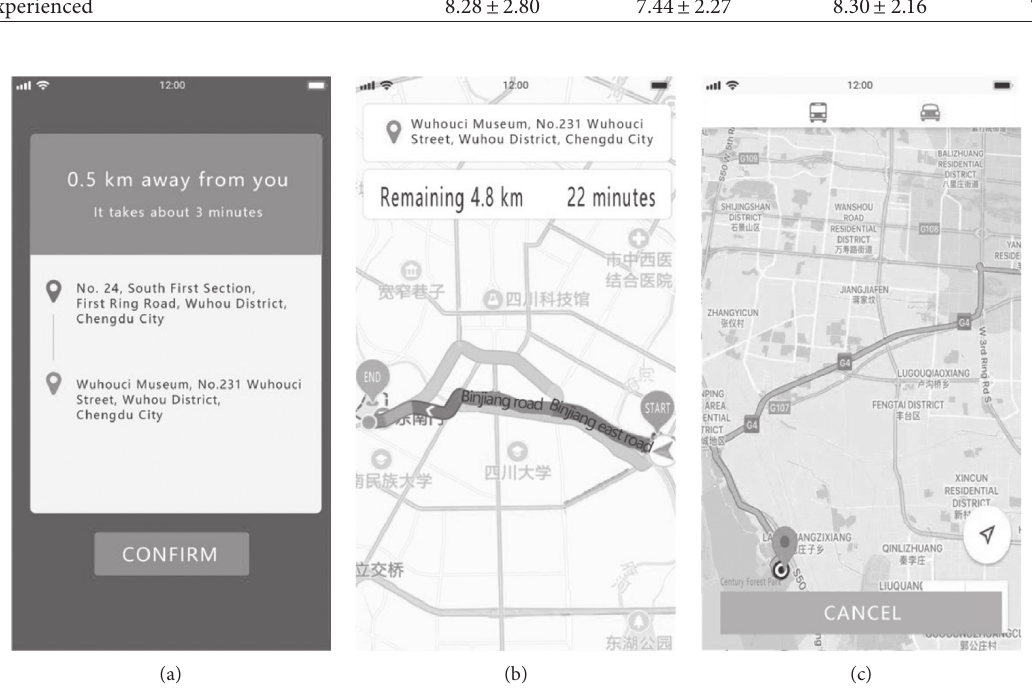
Figure 2: The interface of three experimental demos. (a) Ordering. (b) Information check. (c) Destination